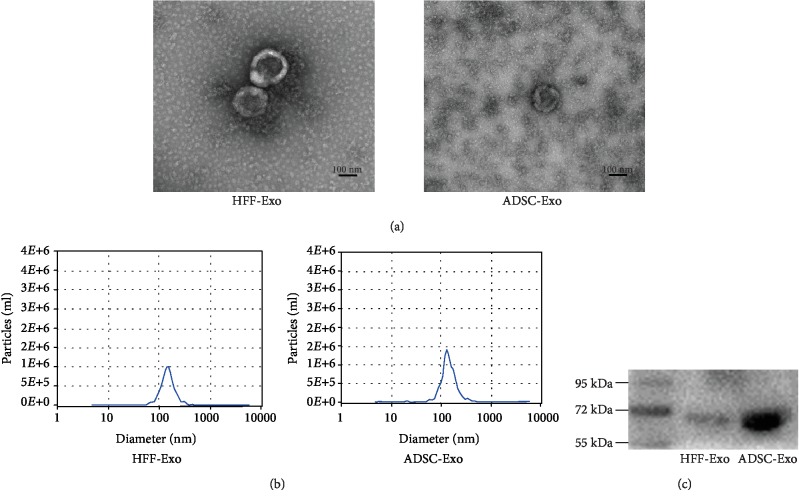
Verification of ADSC-Exo and HFF-Exo. (a) The TEM image of exosomes. (b) Exosome size distribution analysis by NTA. (c) Western blot of exosomes for HSP70.